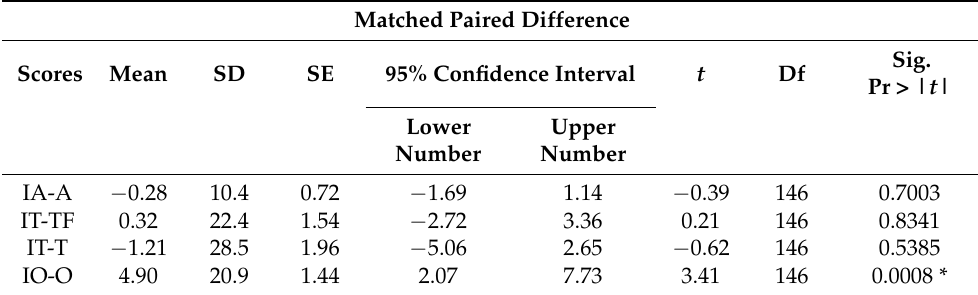
Table 1. Paired t -test comparing sensory mean score of images to real produce under different con- ditions across all commodities.